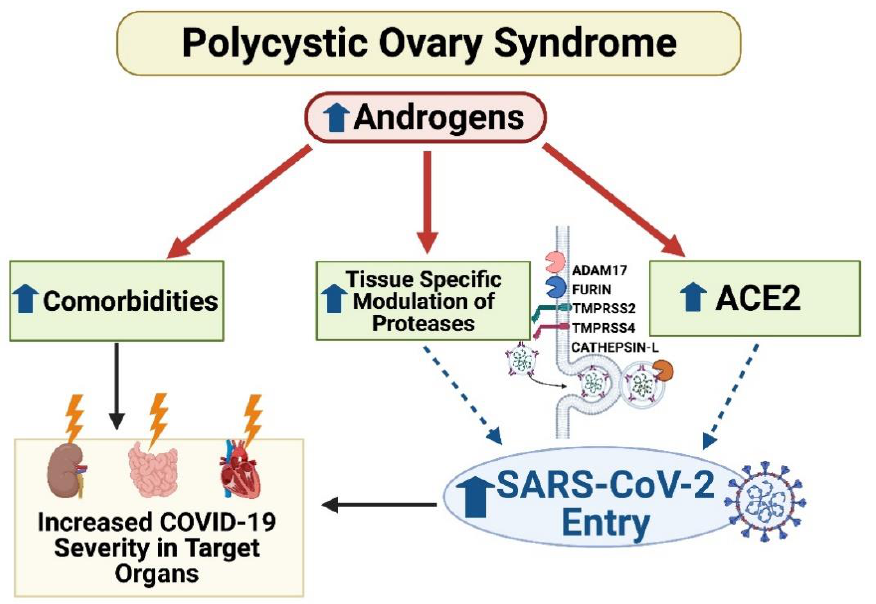
Figure 12. Postulated mechanism of increased SARS-CoV-2 infection and worsened clinical outcomes in PCOS. In PCOS, elevated androgens upregulate the SARS-CoV-2 receptor ACE2 and modify host proteases to increase SARS-CoV-2 viral entry into tissues. Target organs at greatest potential risk primarily include the kidney, the small intestine, and the heart. In conjunction with enhanced viral entry, comorbidities that place individuals at high risk for COVID-19 disease severity coincide with those associated with PCOS, adding to their predisposition for worsened COVID-19 outcomes. Up arrow signifies increase(s); lightning bolt represents injury.